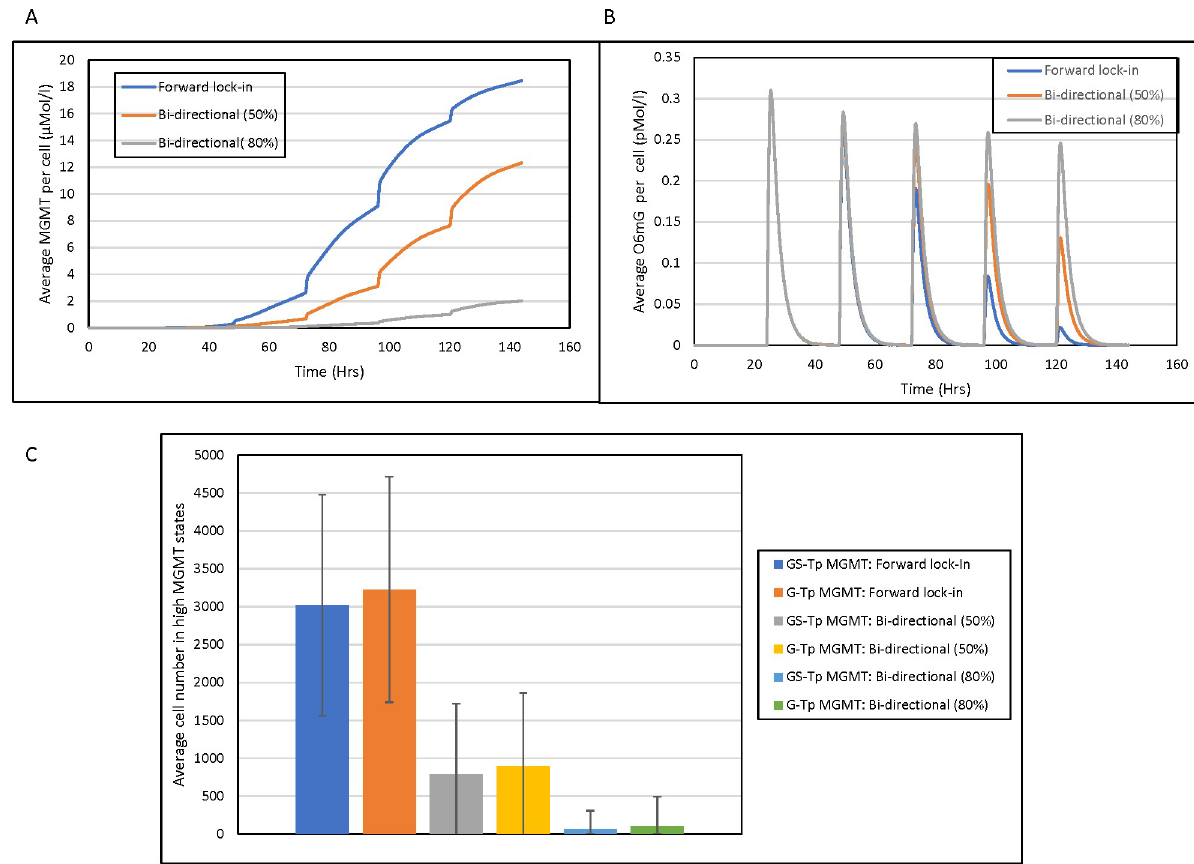
Fig 6. Cell population dynamics for the hybrid stochastic-deterministic TMZ-MGMT model. (A) MGMT concentrations following a multiple- dose TMZ schedule (daily X 5 days) starting at 24 hours without epigenetic instability (blue, forward lock-in) and with either 50% (orange, bi- directional 50%) or 80% (gray, bi-directional 80%) epigenetic instability, (B) O6mG concentrations following a multiple-dose TMZ schedule (daily X 5 days) starting at 24 hours without epigenetic instability (blue, forward lock-in) and with either 50% (orange, bi-directional 50%) or 80% (gray, bi- directional 80%) epigenetic instability. (C) GS-Tp MGMT and G-Tp MGMT cell populations (Average cell number at time = 144 hr) under different conditions. The average concentrations (panel A and B) and cell numbers (+SD) are determined from 2000 independent simulations.